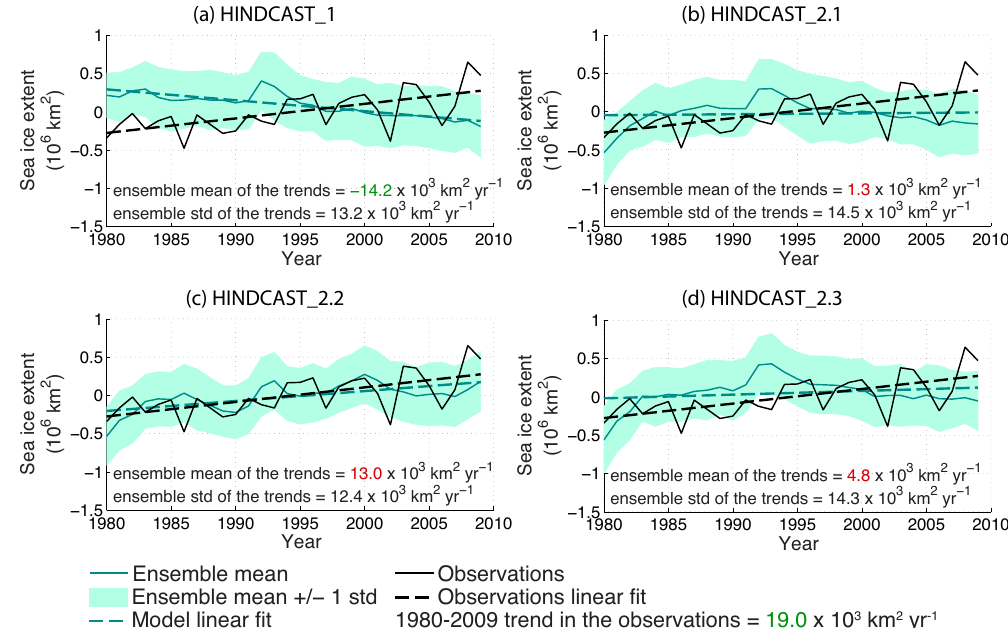
Figure 7. Yearly mean sea ice extent anomalies with regard to 1980–2009, for the four hindcast simulations initialised on 1 January 1980 through data assimilation (see Table 1 for details). The model ensemble mean is shown as the dark green line, surrounded by one standard deviation shown as the light green shading. Observations (Comiso, 1999) are shown as the black line. The green (black) dashed line shows the linear fit of the model simulation (observations). The values of the trend indicated in each panel correspond to the ensemble mean of the trends, computed over the period 1980–2009, along with the ensemble standard deviation. Trends that are (non-)significant at the 99% level are shown in green